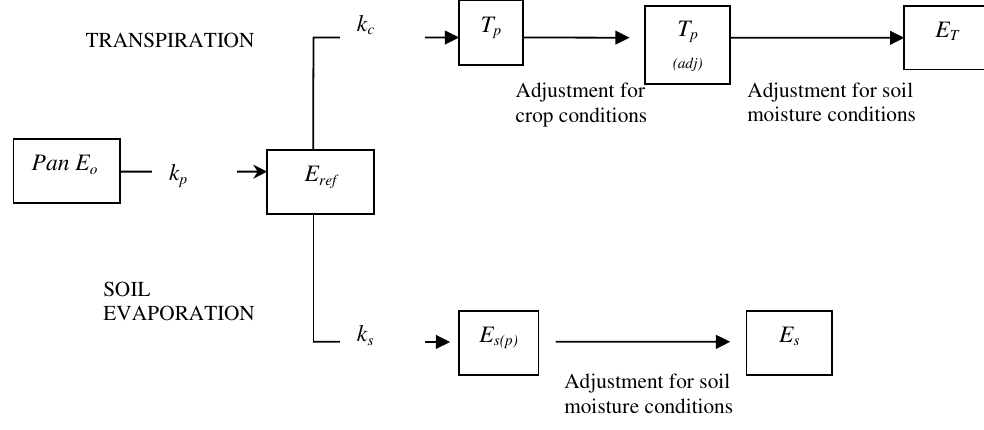
Figure 3: Flow chart for determining evaporation and transpiration Fig. 3. Flow chart for determining evaporation and